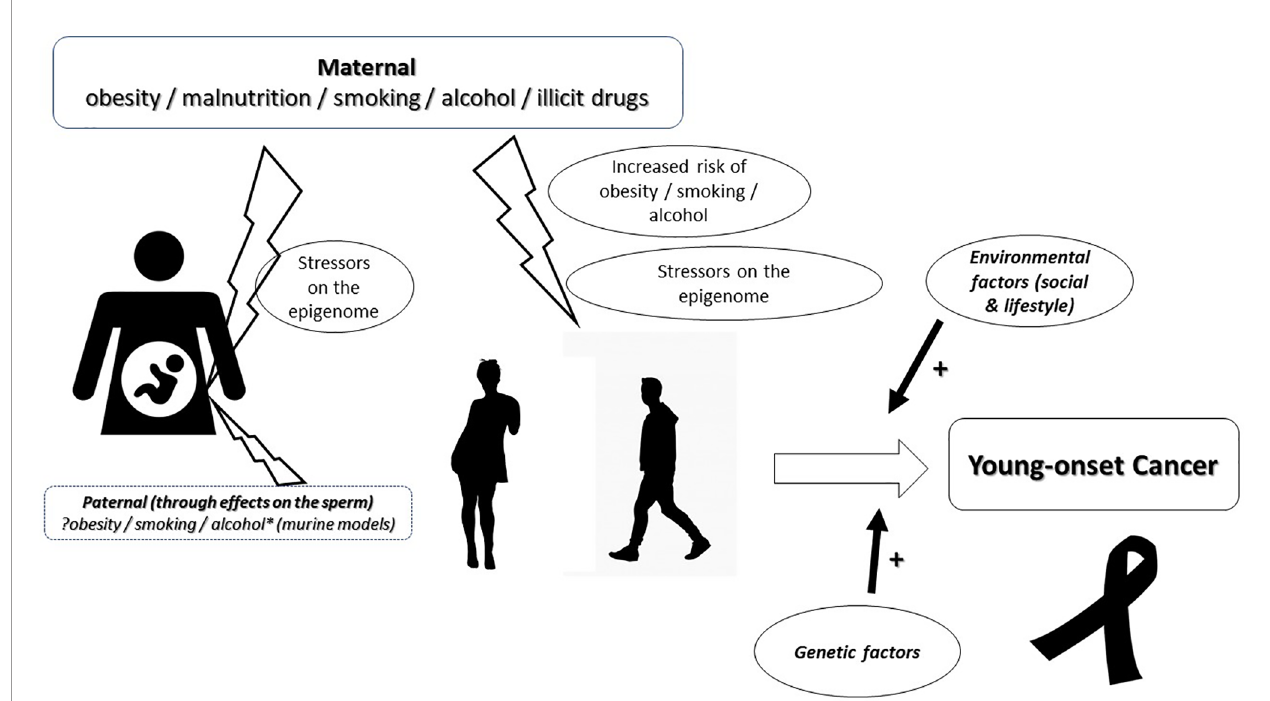
FIGURE 1 | Diagrammatic representation of the hypothesis for the causation of young-onset carcinogenesis. The risk for young-onset cancer begins in utero with exposure of the foetus to maternal, stressors. The possibility of a paternal contribution through the damaging effects of stressors on the sperm are considered and warrant consideration. Exposure to the same stressors, during adolescence or young adulthood, facilitates a re-activation of these ‘ responses designed to be protective ’ but ultimately resulting in a loss of regulation at a metabolic and/or genetic level culminating in the evolution of the neoplastic process as a result of a cumulative effect with environmental and other genetic